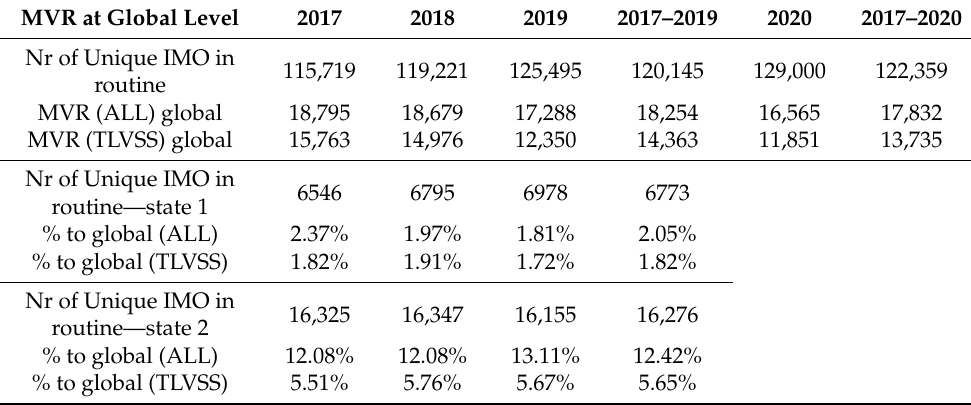
Table 2. MVR at global and regional level (MVR in million USD).